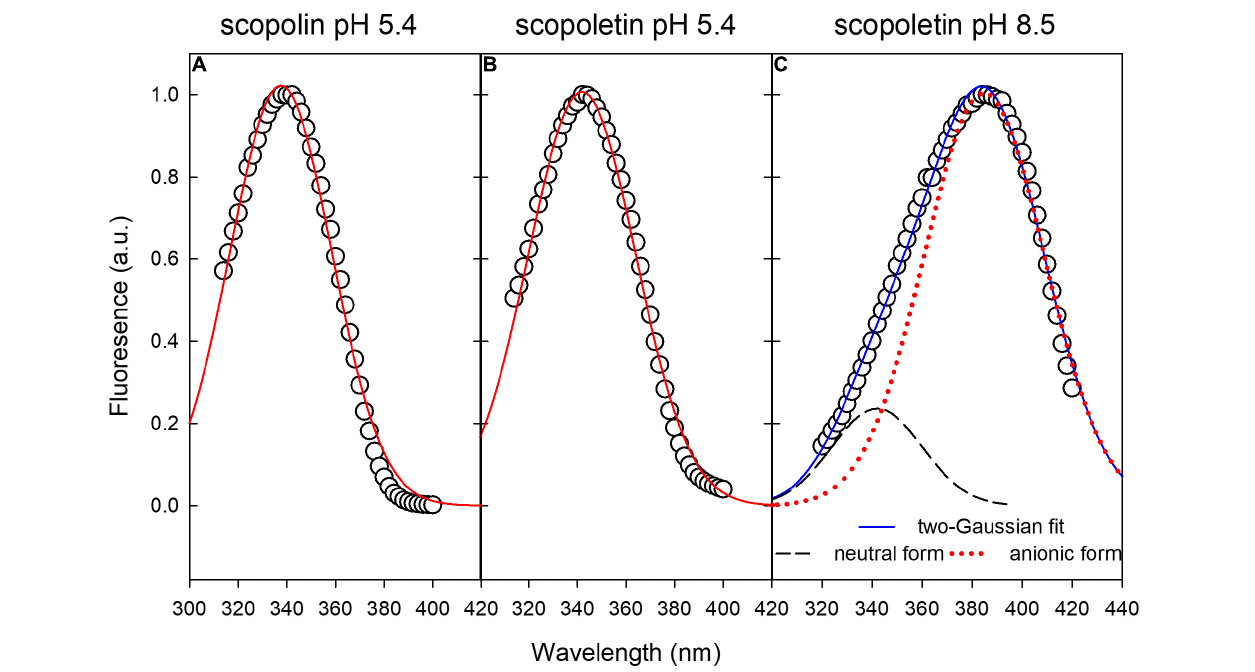
FIGURE 6 | Gaussian fitting of excitation fluorescence spectra of standard compounds in buffer solution. (A,B) Single-Gaussian curve fitting of SCL and SCT at pH 5.4, respectively. (C) Two-Gaussian curve fitting to take into account the residual component from the neutral form of SCT.